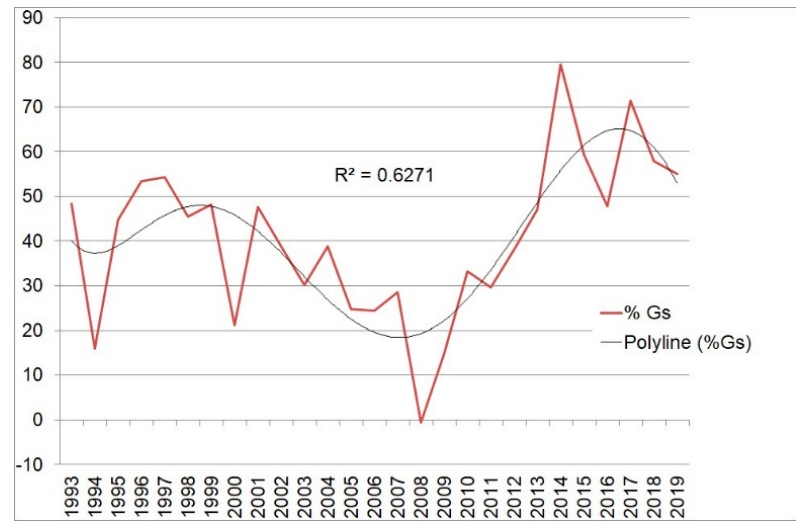
Figure 3. Temporal trend of groundwater source percentage (red line) and the polyline (black line).